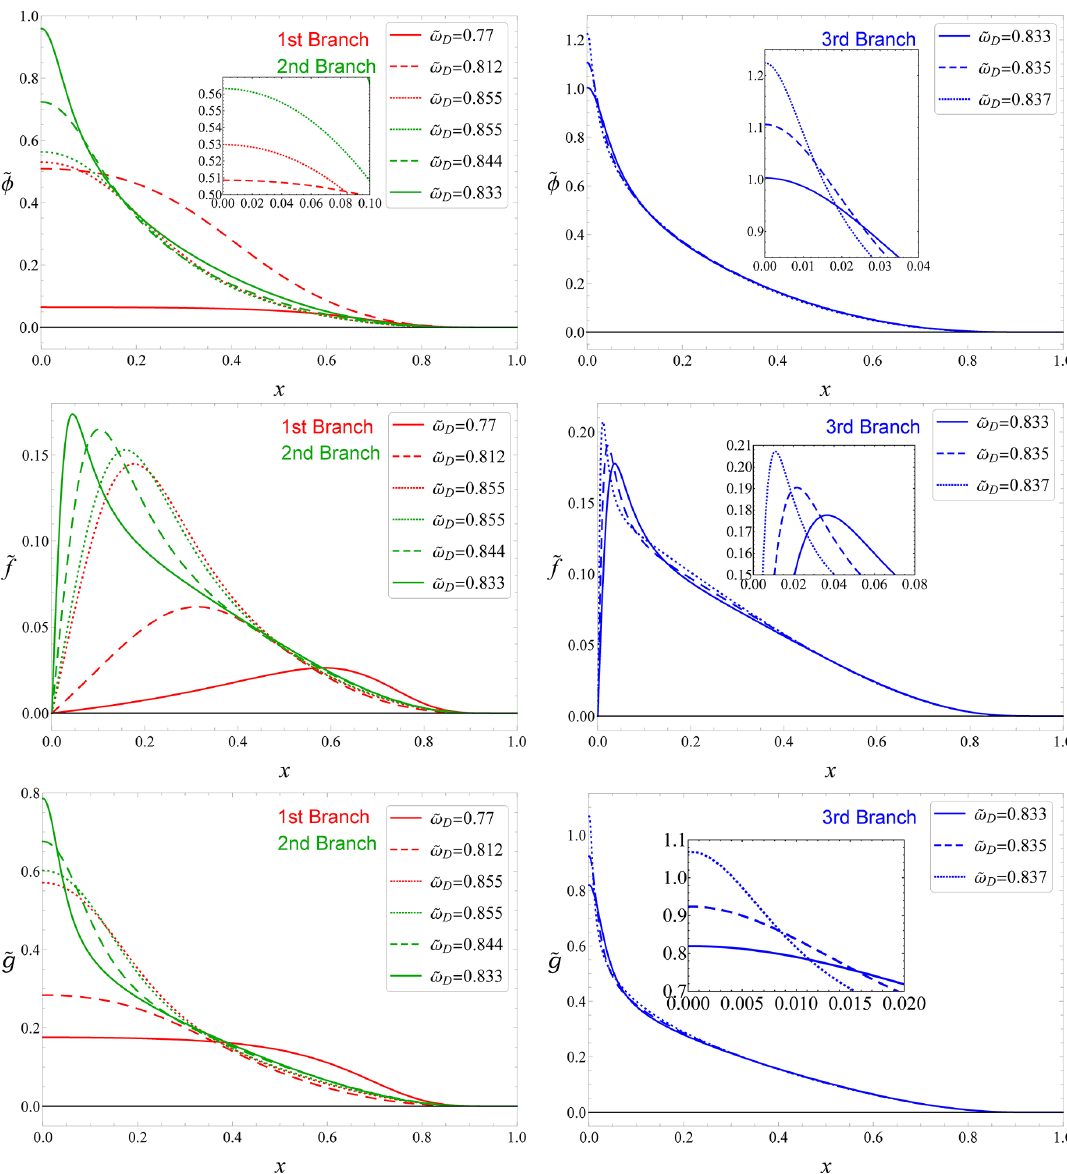
Figure 7. Scalar field function ˜ φ (top panels) and Dirac field functions ˜ f (middle panels) and ˜ g (bottom panels) as functions of x with several values of nonsynchronized frequency ˜ ω D , where the field functions on the first, second and third branches are represented by the red, green and blue lines. All solutions have ˜ ω S = 0 . 749 and ˜ µ S = ˜ µ D = 1